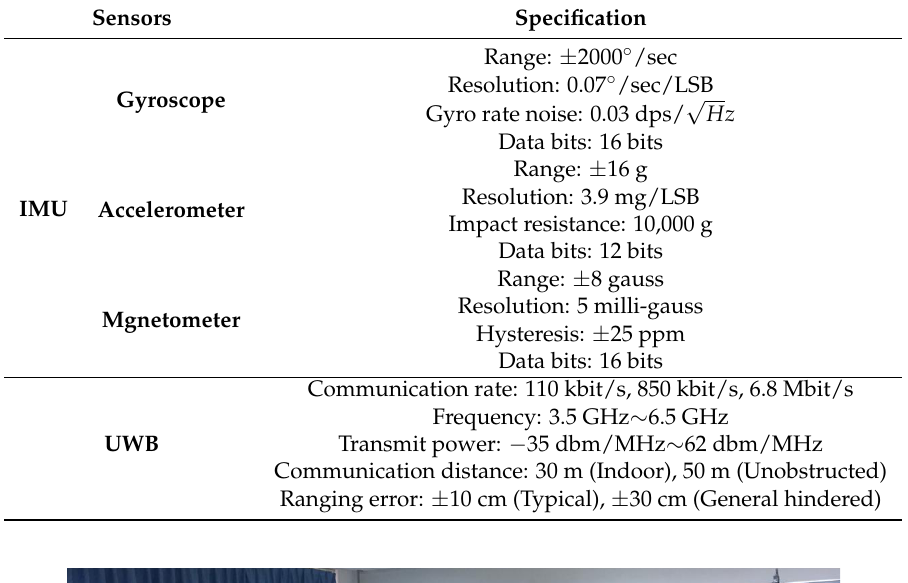
Figure 9. The hardware communication of INS/UWB integrated system. Table 2. The technical specifications of sensors.